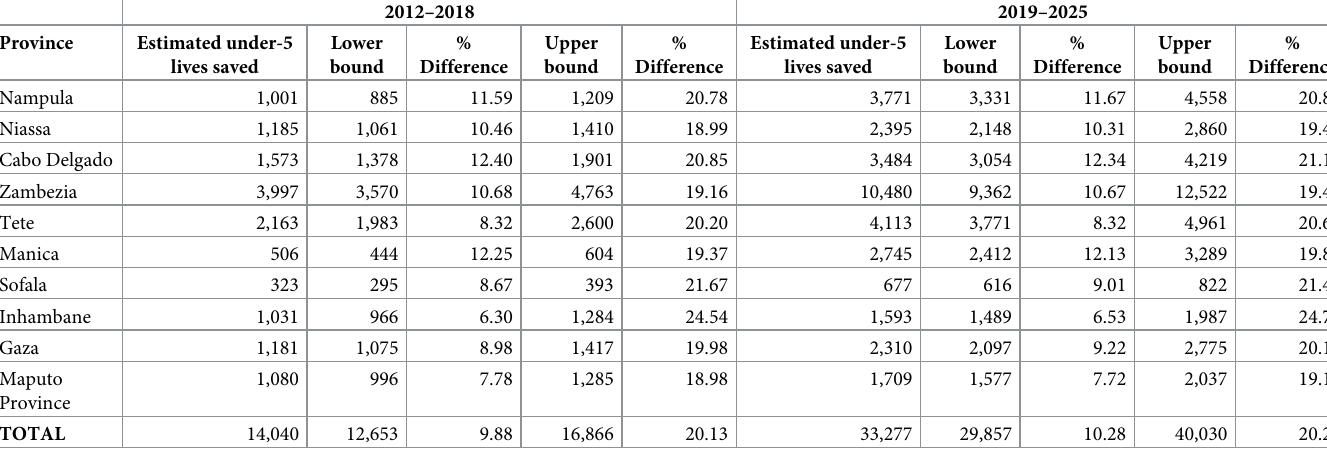
If all ten provinces reach at least 85% coverage by 2022 and maintain 85% coverage until 2025, an additional 2,786 under-5 lives are expected to be saved, besides the 33,277 already expected with 2018 coverage levels, for a total of 36,063 estimated deaths avoided between 2019 to 2025 due to household ITN distribution ( Fig 4 ). Complete data tables of estimated under-5 lives saved by year and by province can be found as S1 and S2 Tables. Sensitivity analysis. For each province, we used LiST to approximate the 95% confidence intervals for the upper and lower bounds on the point estimate of the total number of deaths averted of children under-5 from 2012 to 2018, and 2019 to 2025 ( Table 2 ). From 2012 to 2018, the percent difference between the lower bound and the point estimate was about 10% Table 2. Sensitivity analysis with 95% confidence intervals around the effectiveness of ITN/IRS coverage in order to estimate the upper and lower bounds on the number of child lives saved, by province, 2012–2018 and